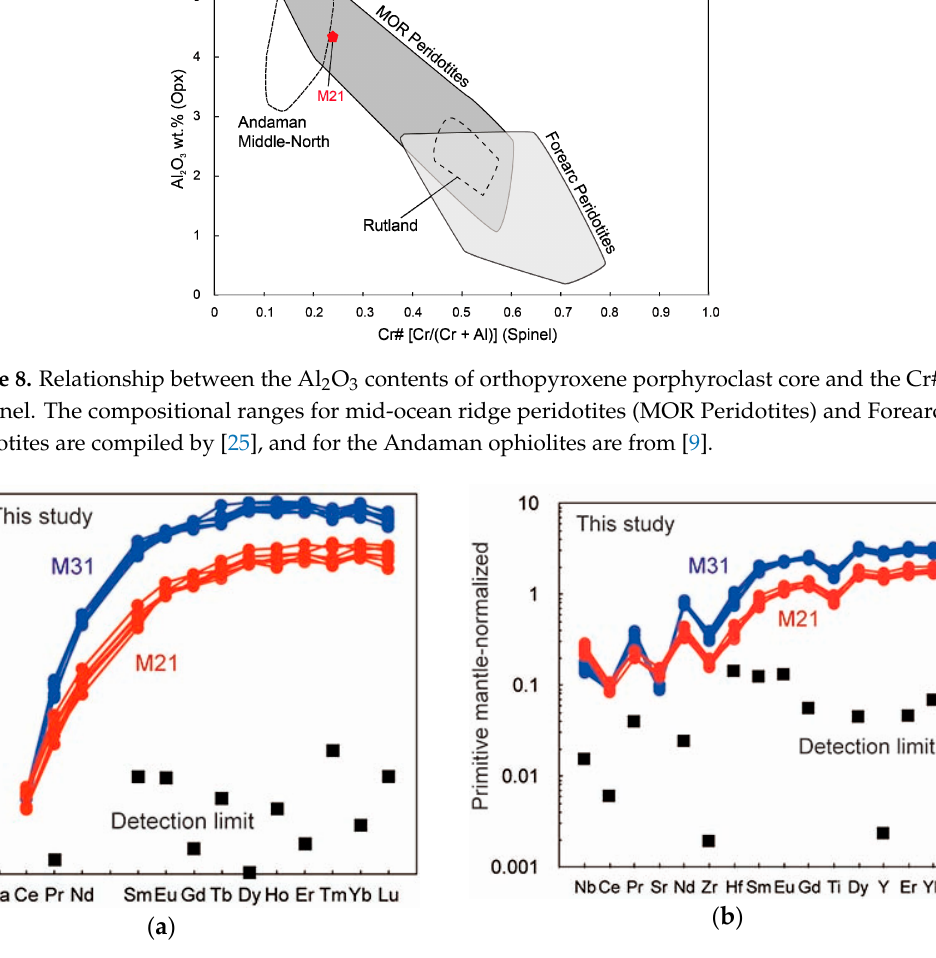
Figure 9. ( a ) Chondrite-normalized REE patterns and ( b ) primitive-mantle-normalized trace element patterns of the M21 (Red) and M31 (Blue) lherzolite clinopyroxenes. Data are from [4]. The typical detection limit of elemental analyses is also shown for 60 µm that was used for obtaining trace element compositions of clinopyroxenes. Chondrite and primitive mantle values are from [26].